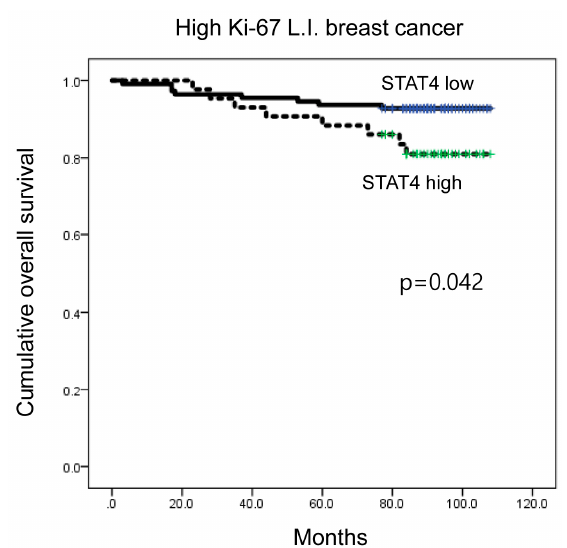
Figure 4. Impact of immune cell subtype-related protein expression on patient prognosis (overall survival, OS). In high Ki-67 L.I. breast cancer, high STAT4 expression was associated with shorter OS ( p = 0.042). L.I.: labeling index.